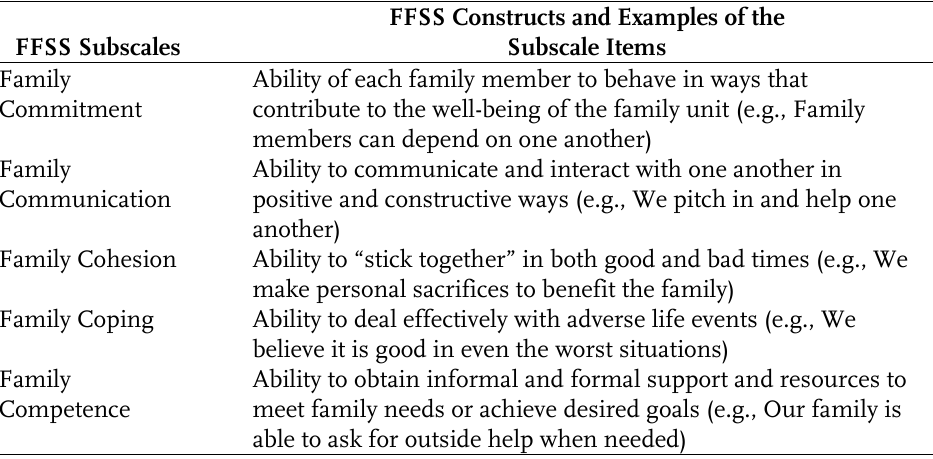
Table 2 : Descriptions of each of the family functioning style subscale constructs FFSS Constructs and Examples of the FFSS Subscales Subscale